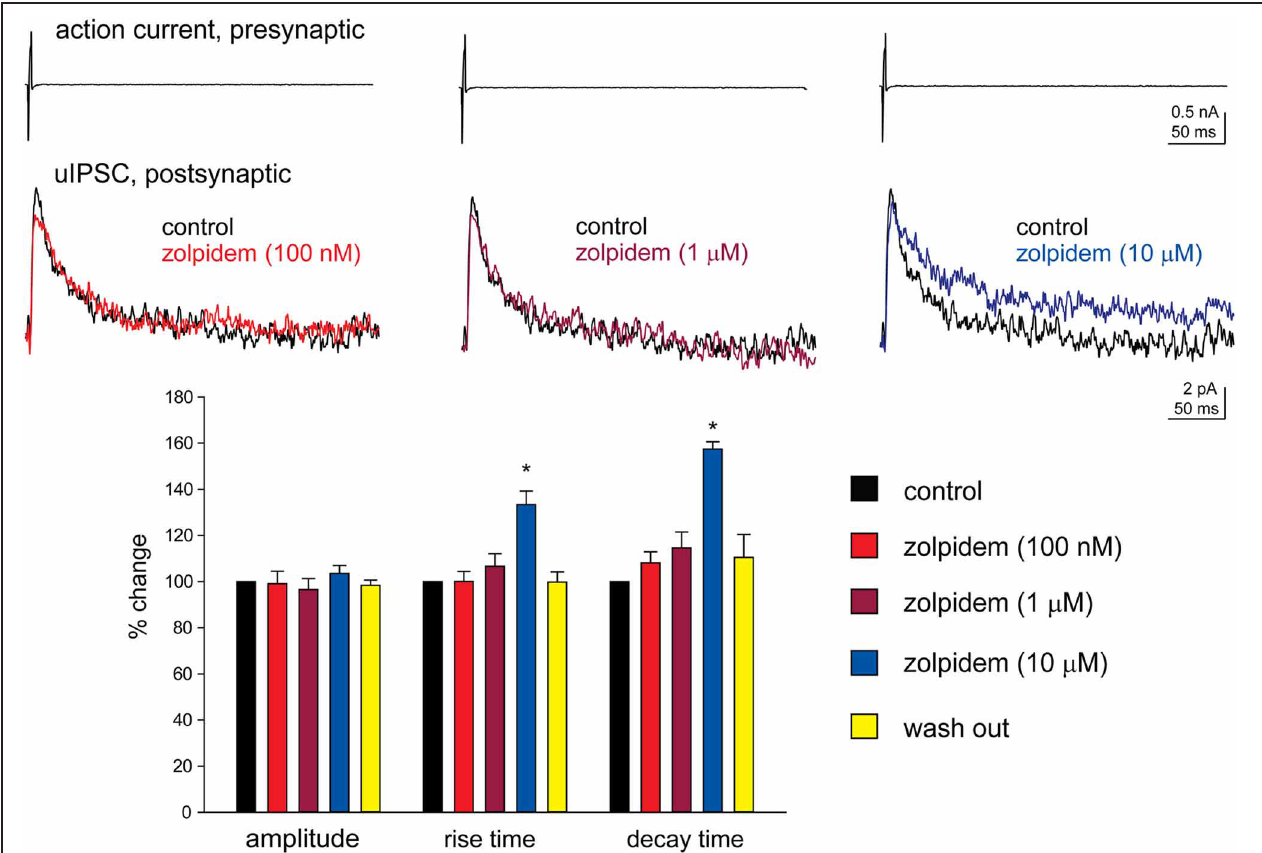
FIGURE 1 | High, but not low, concentration of zolpidem increases the decay time constant of Imp-mediated uIPSCs. Upper traces: whole-cell patch clamp recording of two-synaptically coupled Imp neurons from an acute slice of amygdala. A short (3ms) voltage step to + 20mV elicited an action current in the presynaptic cell that evoked a uIPSC in the postsynaptic cell. Each trace is the average of 10 consecutive sweeps (0.1Hz), recorded with a K-gluconate-based solution at the holding potential of − 55mV. In the